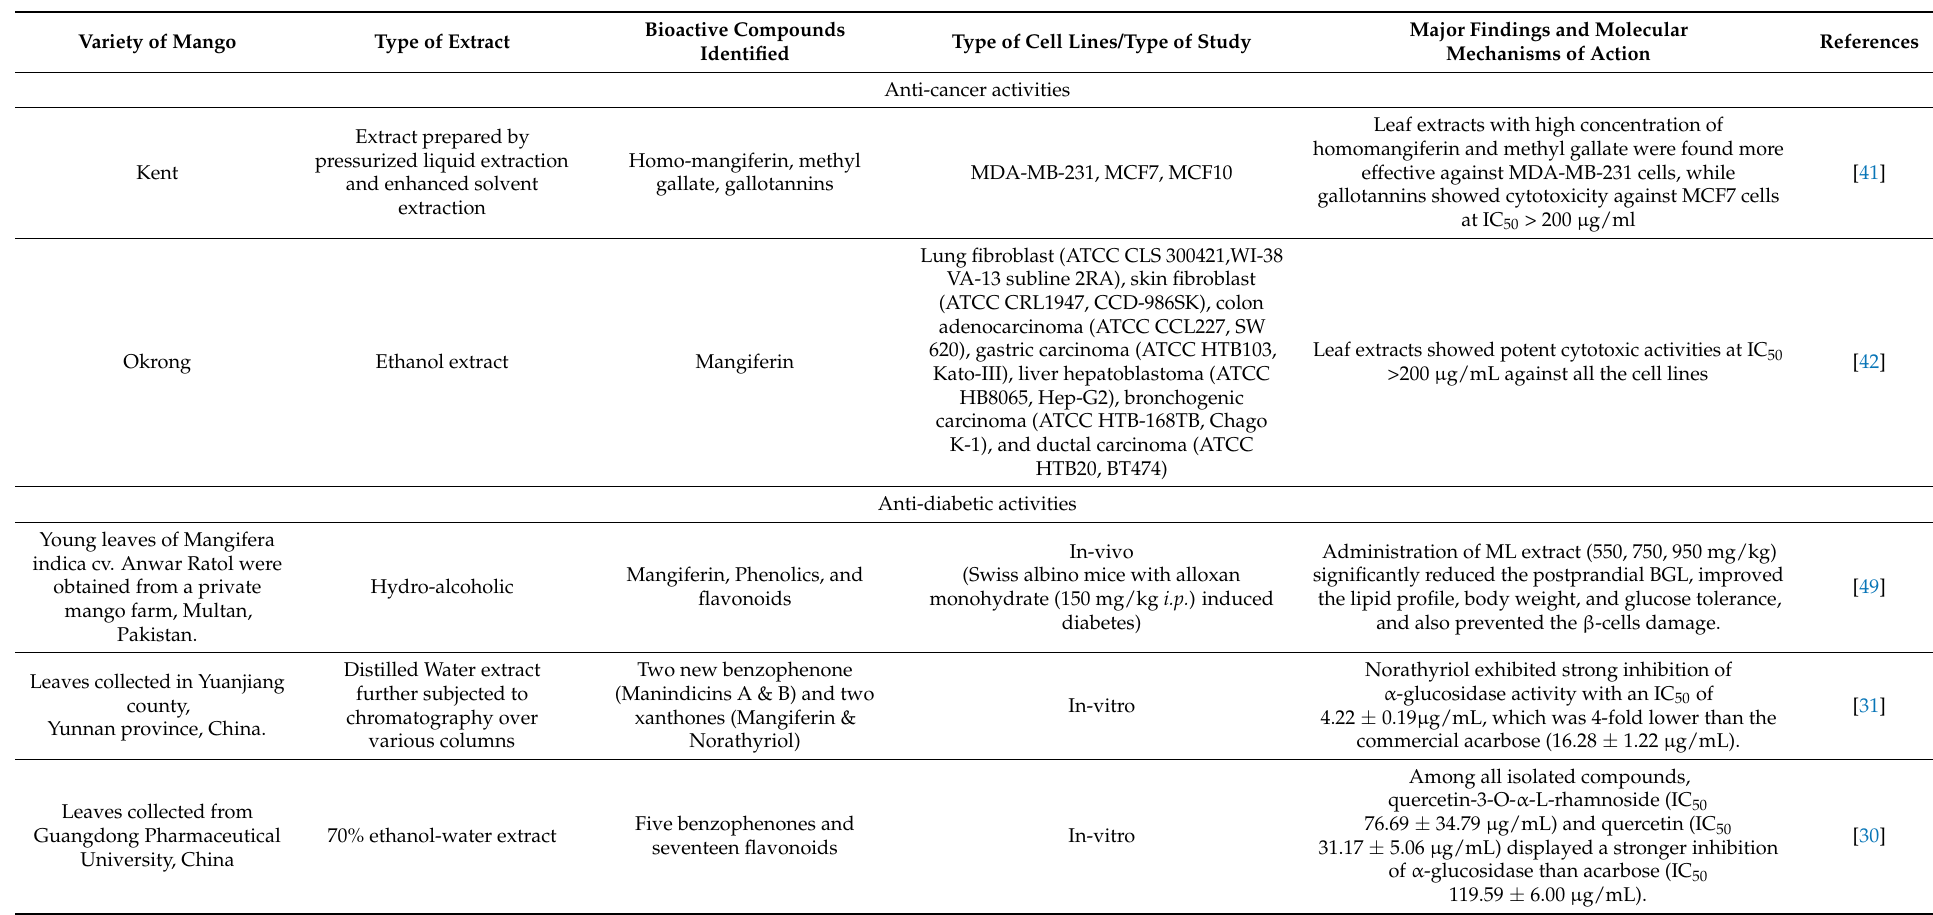
Table 4. Health promoting activities of mango